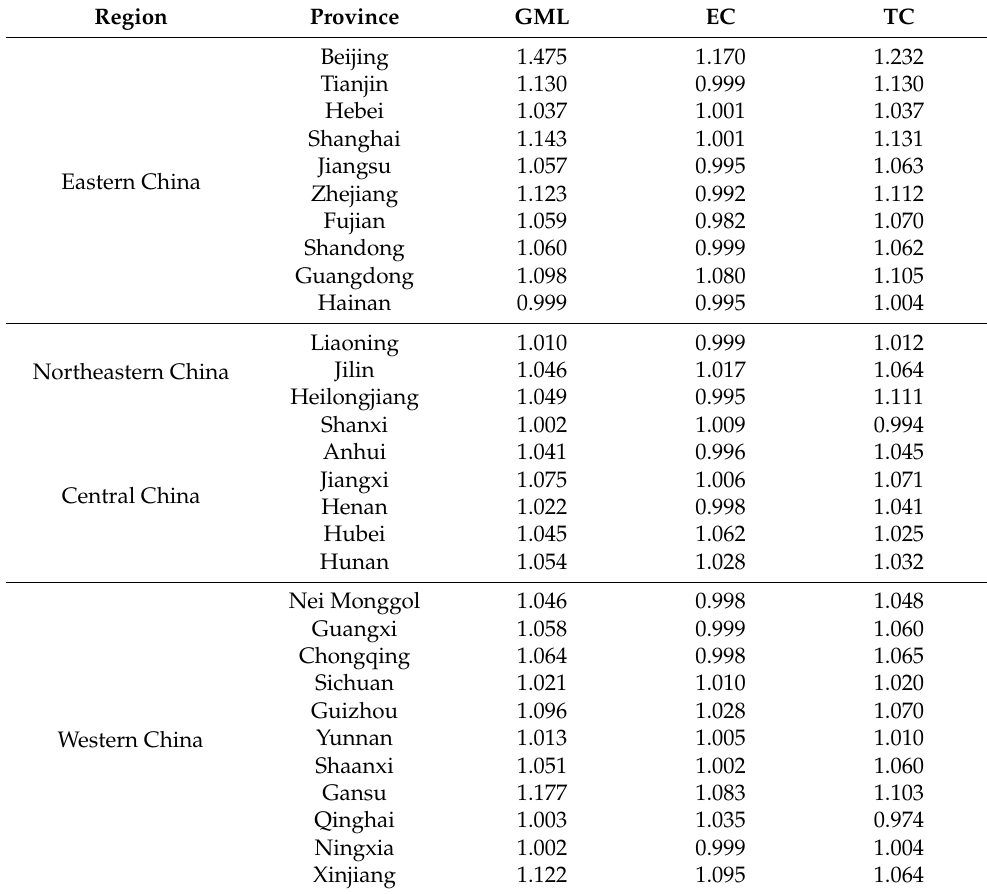
Table 5. Average annual GML index and its decomposition by province from 2008 to